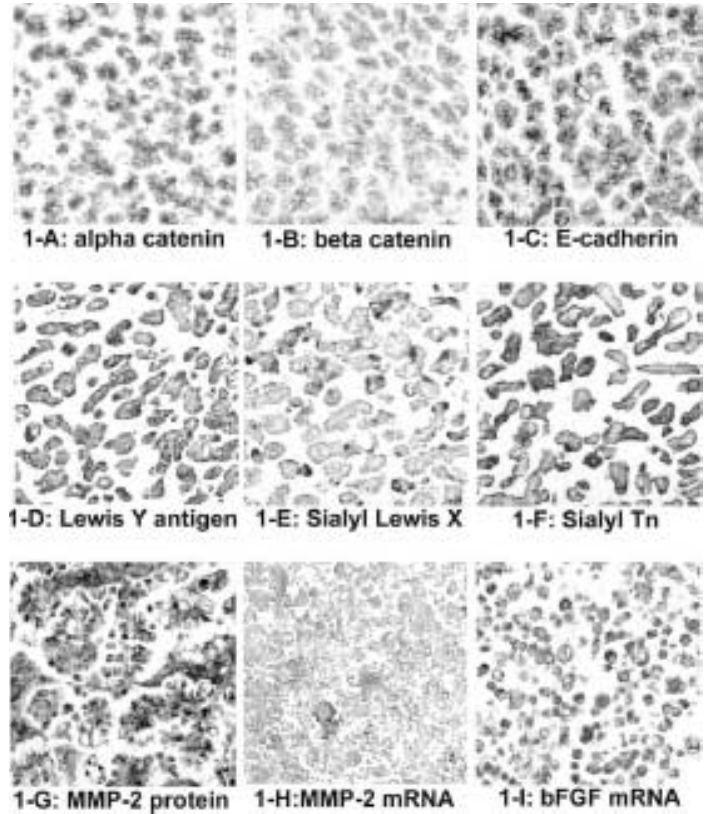
Fig. 1. Expression of metastasis-associated molecules in ovarian carcinoma cells in effusions. Figures 1-A to 1-C: Protein expression of E-cadherin complex molecules. Figures 1-D to 1-F: Carbohydrate antigen expression. Figure 1-G: Protein expression of the protease matrix metalloproteinase-2 (MMP-2). Figure 1-H: mRNA MMP-2 expression. Figure 1-I: mRNA expression of the angiogenic molecule basic fibroblast growth factor (bFGF). This figure can be viewed in full colour on: